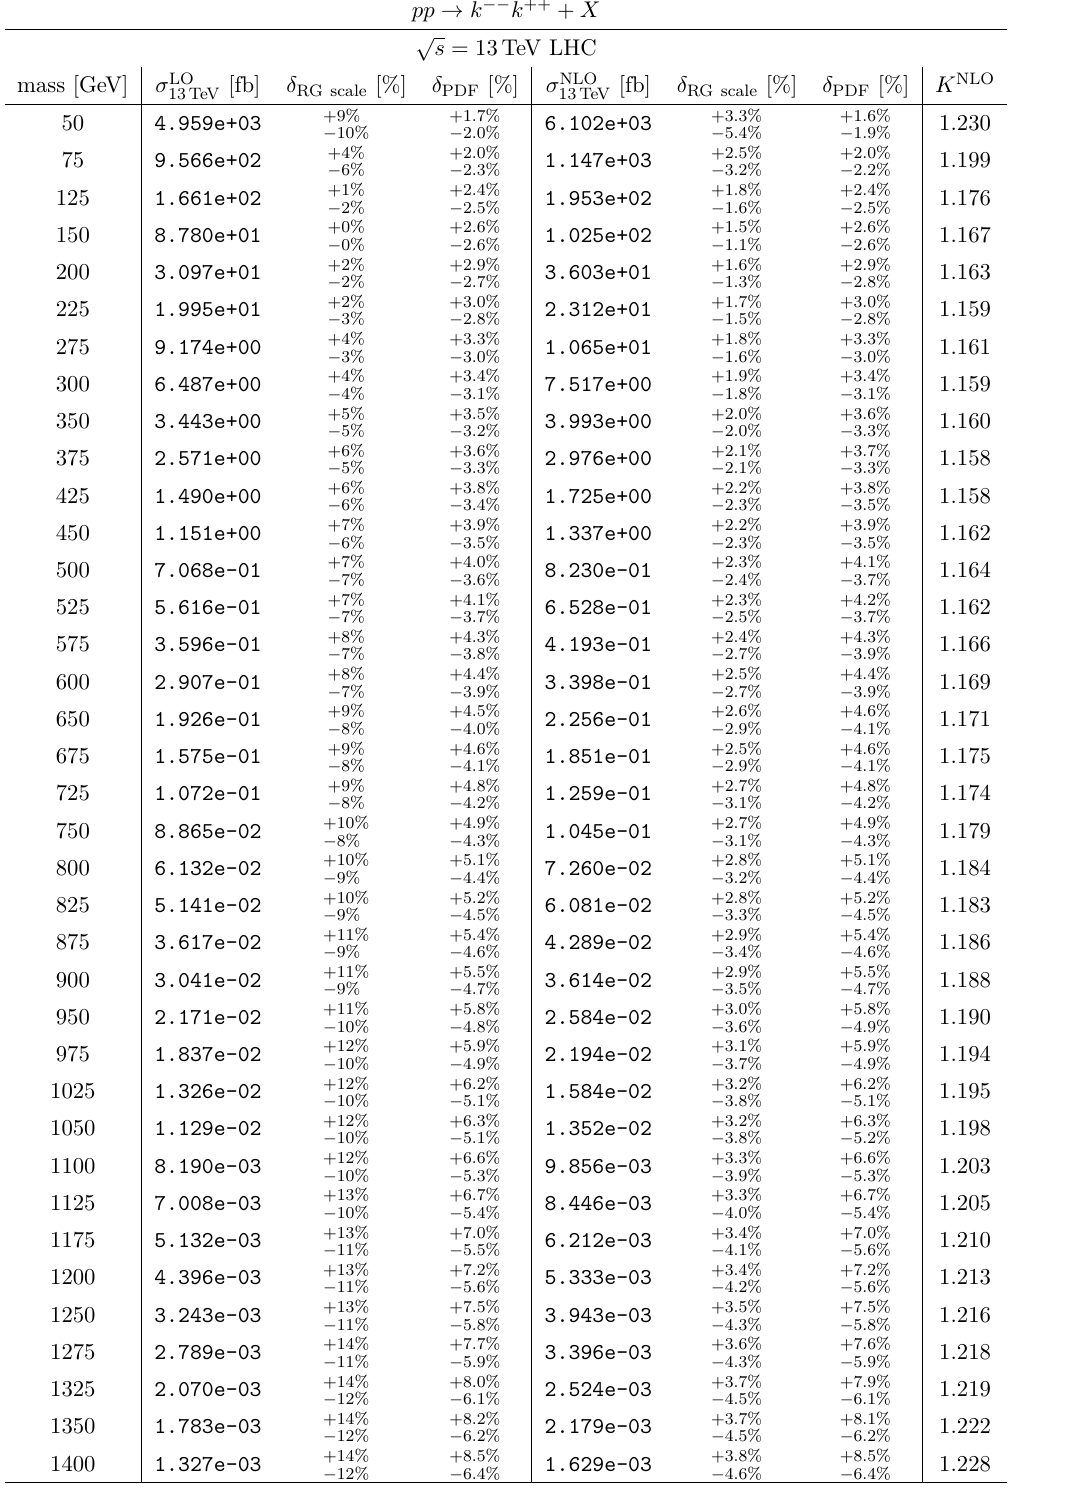
Table 6 . For representative masses m k [GeV] (first column), the predicted cross sections [fb] for √ s = 13 TeV at LO (second column) and NLO (third column) in QCD for inclusive pp → k −− k ++ + X via the Drell-Yan process (DY). Also shown are scale uncertainties [%], PDF uncertainties [%], and the QCD K -factor. See section 3.2 for SM